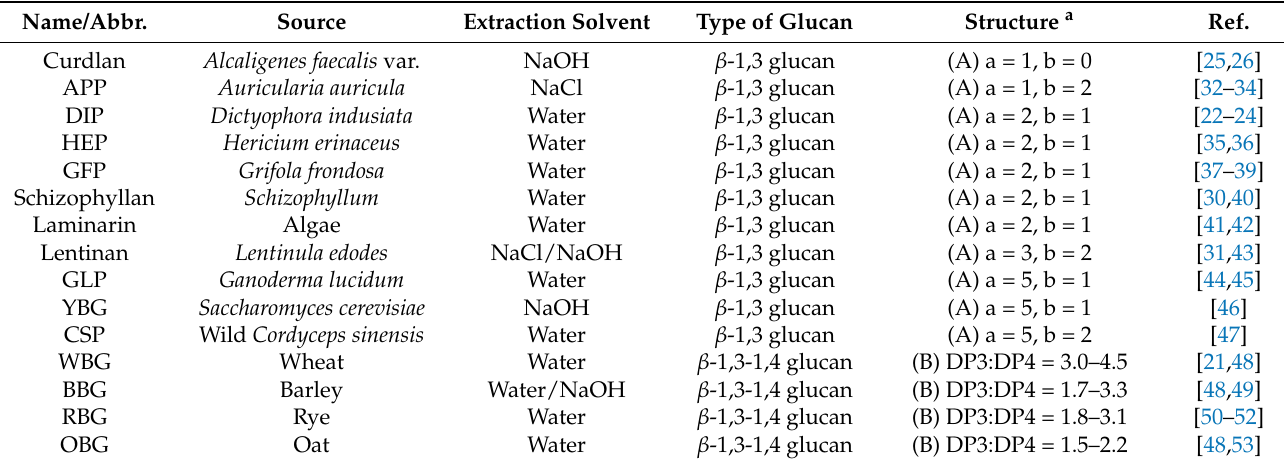
Table 1. Sources and deduced chemical structures of several β -glucans.